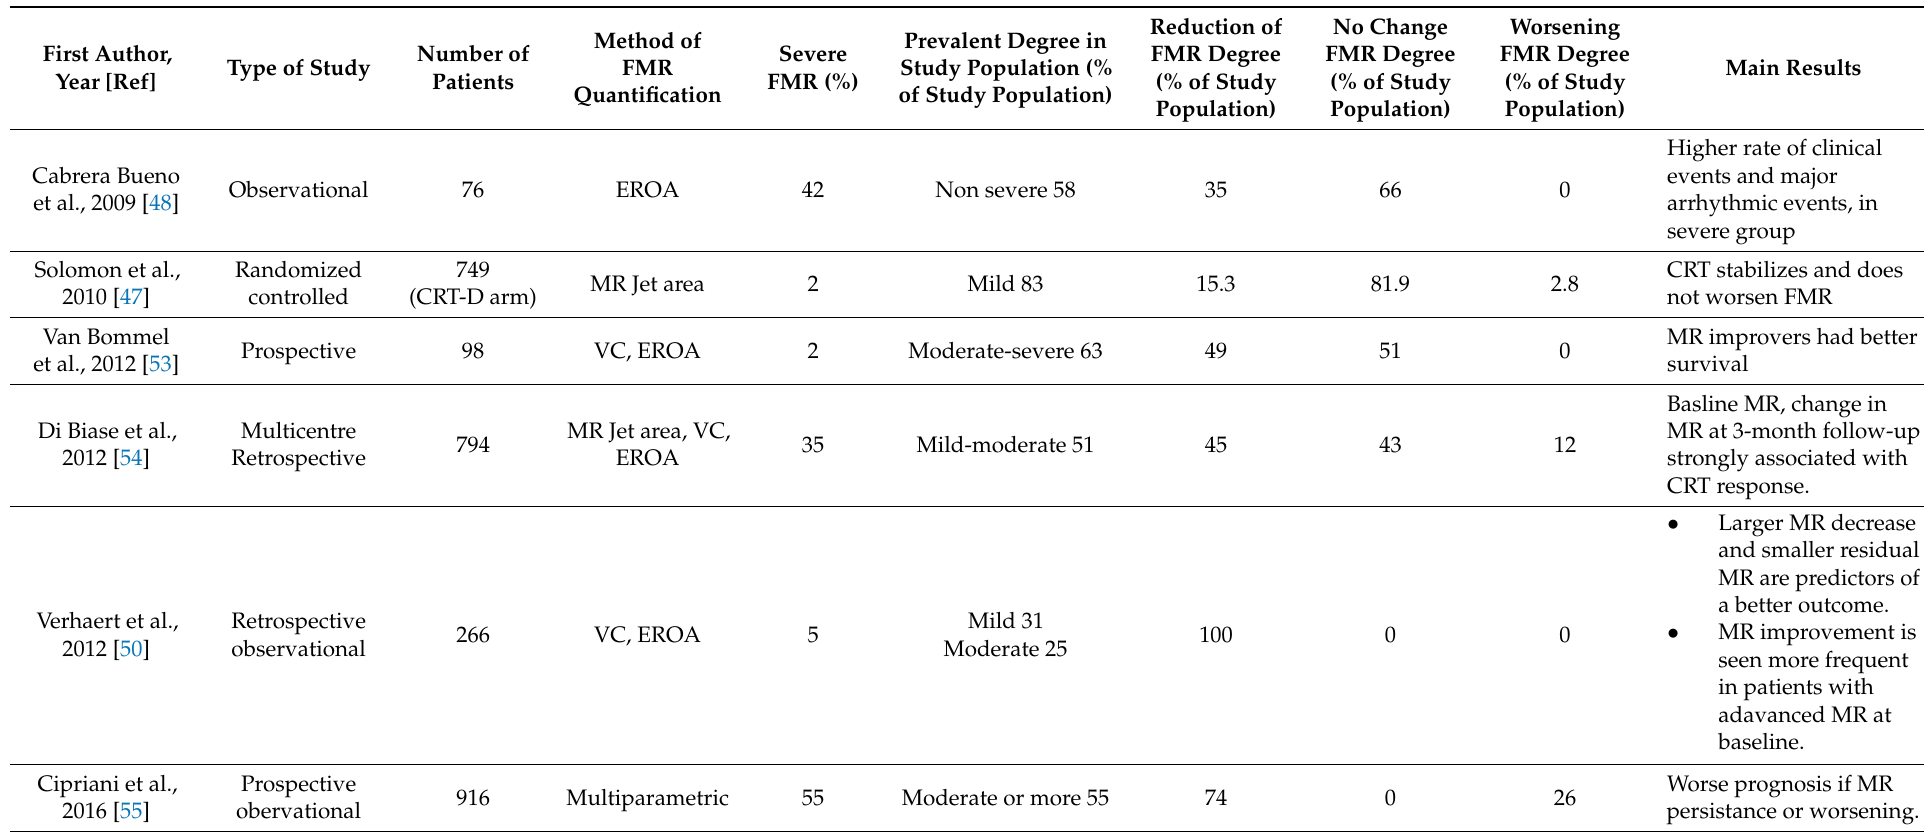
Table 1. Trials and studies evaluating prevalence of FMR of various degrees in CRT